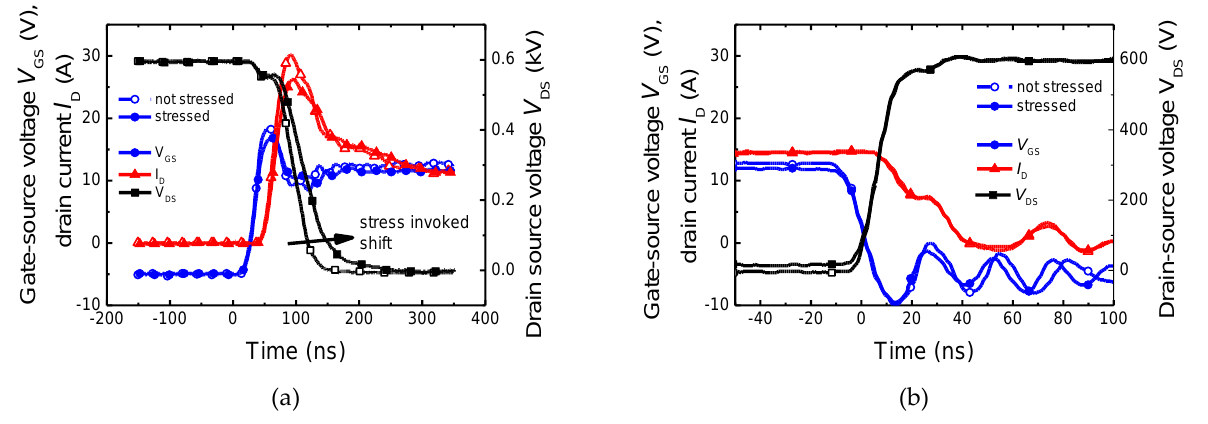
Figure 4. Impact of repetitive UIS on switching performance of the power SiC TrenchMOS. ( a ) Turn-on and ( b ) turn-off the process. A significant increase in turn-on time was observed after 10 million UIS pulses. No impact on the turn-off process was observed. Open symbols mean the values correspond to virgin samples, while the filled symbols represent the measurement after 10 million UIS pulses.